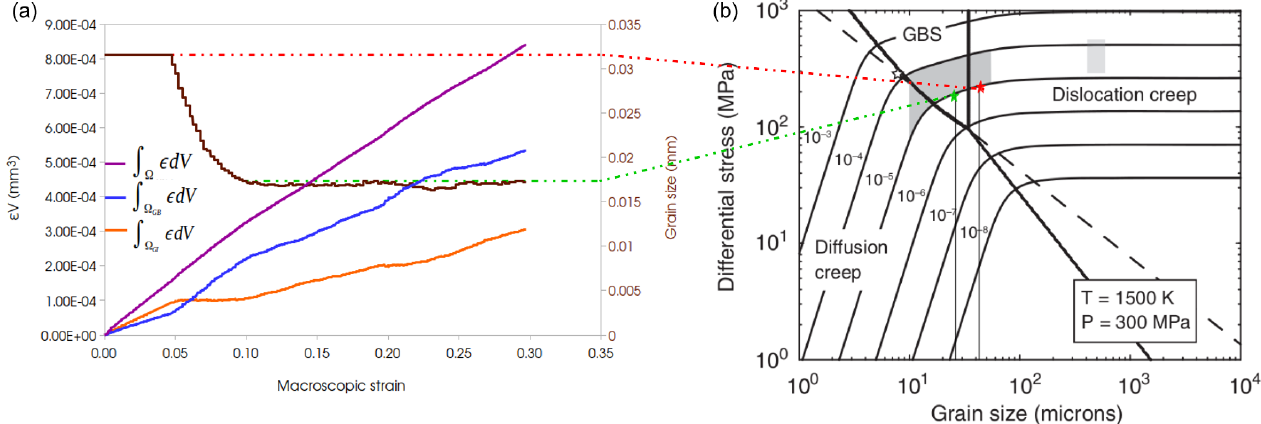
Figure 4. (a) Equivalent strain integrated (see Eq. 23) over the whole polycrystal (purple), grain boundaries (blue) and grain interiors (orange), and integrated over time. Mean grain size evolution during deformation (brown) and the corresponding thermomechanical conditions and mean grain size in an olivine deformation map (b) from Skemer et al. (2011); the two stars have been positioned according to the imposed strain rate and they correspond to a simulated stresses of 190MPa (red) and 130MPa